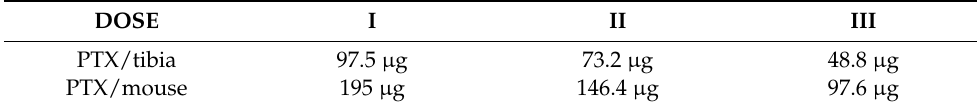
Table 1. Summary of the tested dose of PTX in PTX-Ce6@ker nanoformulation. DOSE